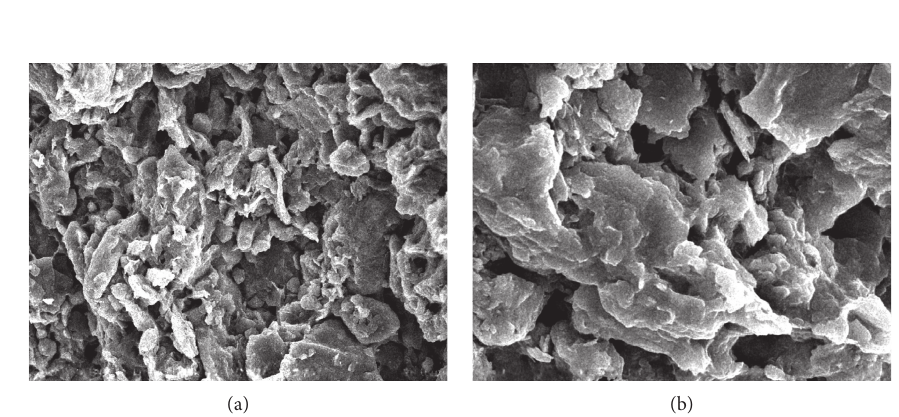
Figure 12: The SEM images with 90% compactness: (a) 1000 times; (b) 3000